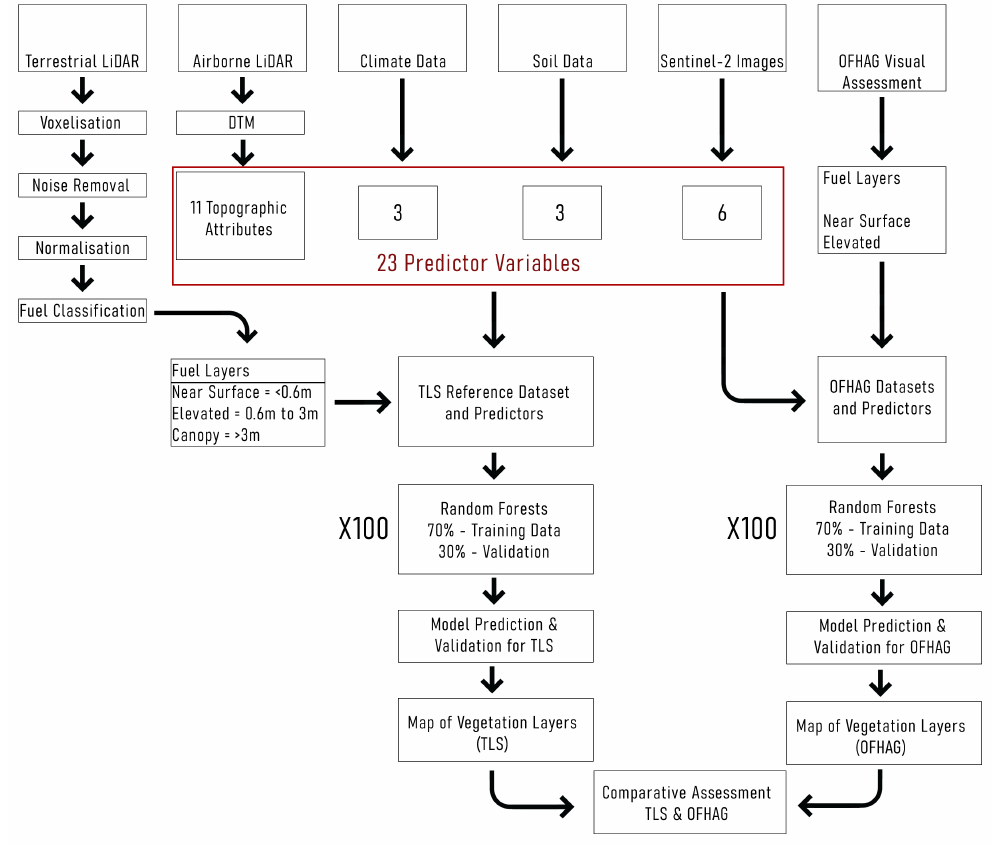
Figure 2. The workflow used to generate prediction of fuel properties (near-surface and elevated fuel cover and height) for the extent of an area that needed to be